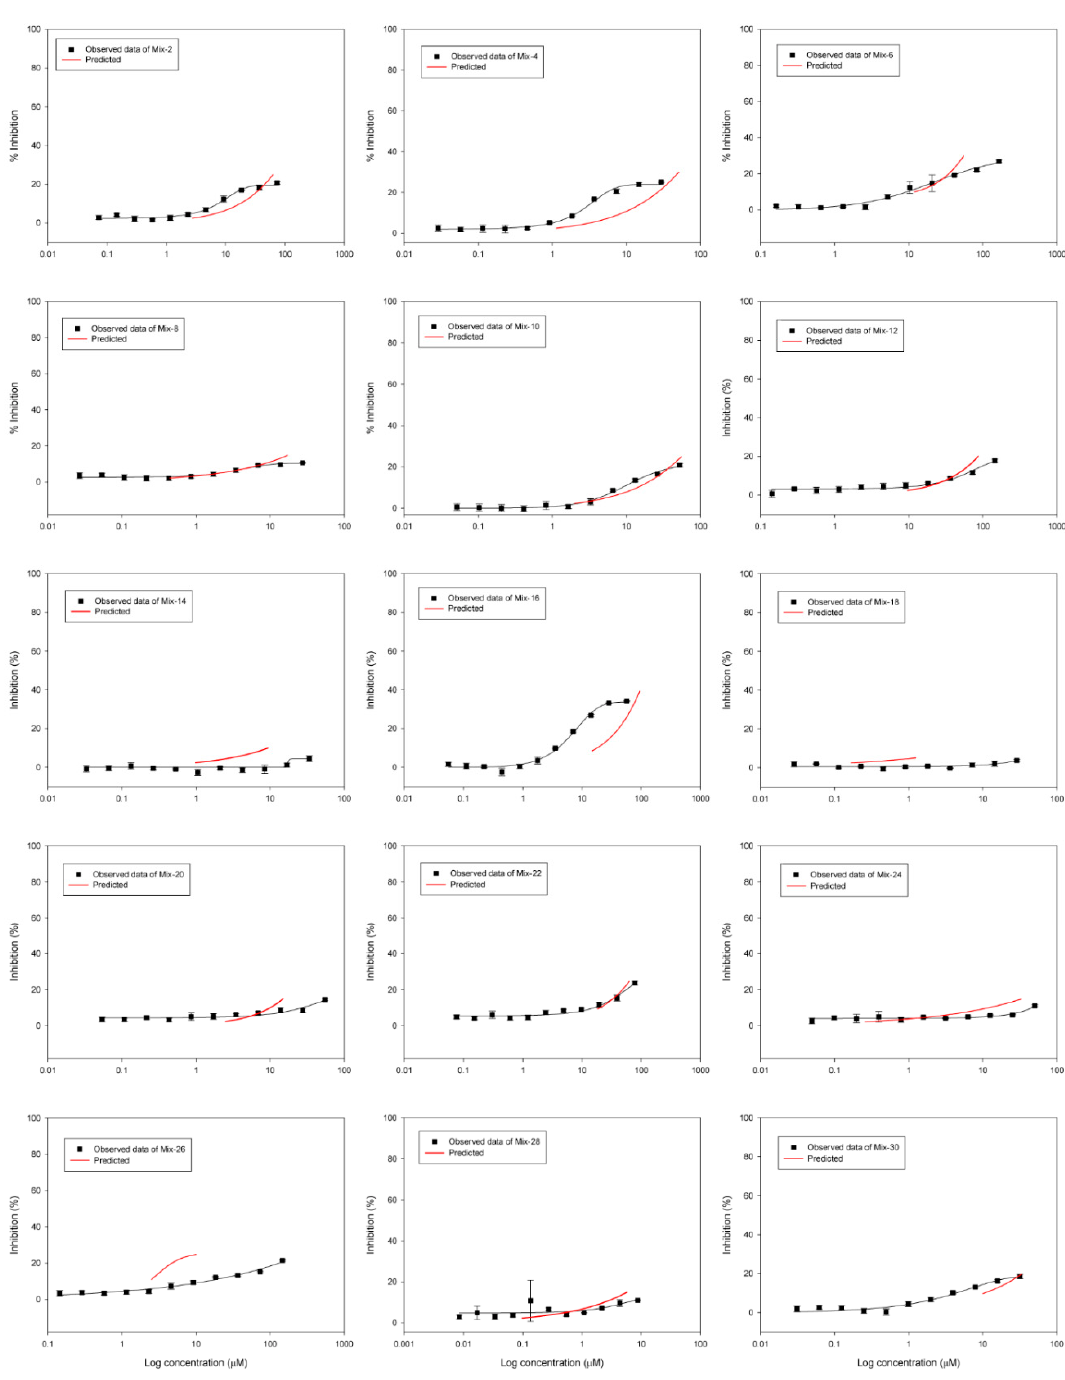
Figure 3. The DRCs for the observed bioluminescent inhibitions and the predicted inhibition (red lines) for the CA model for in the binary equitoxic mixtures and based on ratios at 10% effective concentrations for each component (the data points are geometric means ± standard deviation (SD)of experimentally observed data, and statistical best-fits for regression models are summarized in Table 3). The dose-response curves of 30 binary mixtures of pesticides and pharmaceuticals in Table 1, respectively.